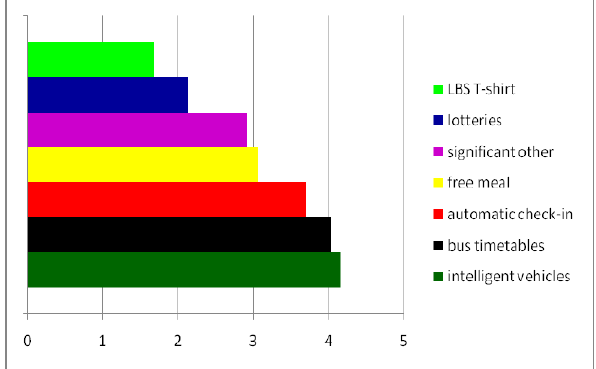
Figure 18. Users’ opinions about potential LBS that might increase social wellbeing. Scale from 1 (don’t see any social benefits in terms of increasing the people wellbeing) to 5 (see a lot of potential benefit in terms of increasing people’s wellbeing).